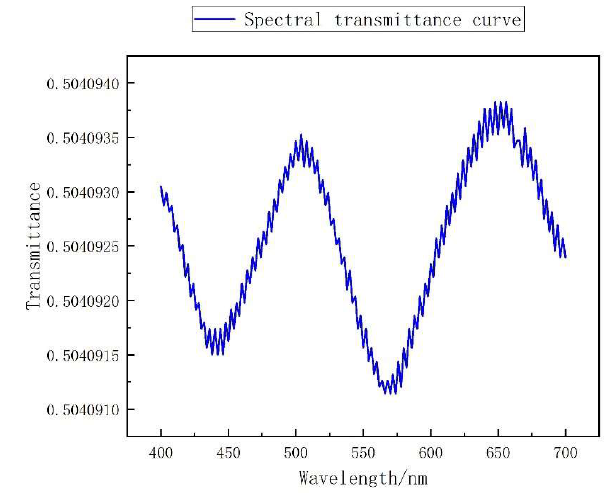
Figure 3. Jittering spectral transmittance curve.